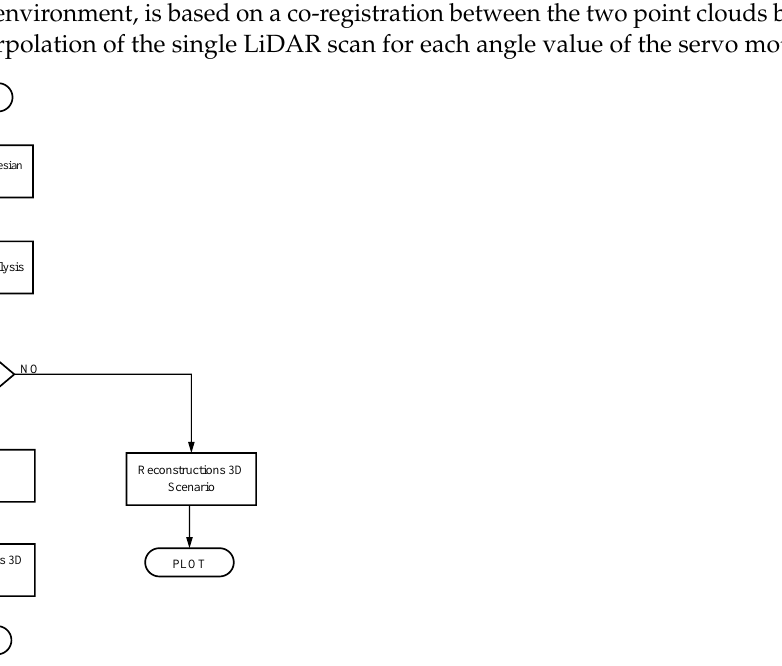
Figure 16. Flowchart of the extrinsic calibration procedure.